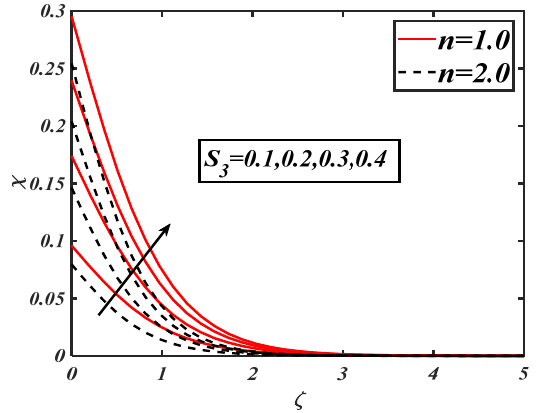
Figure 23. N illustration against χ .